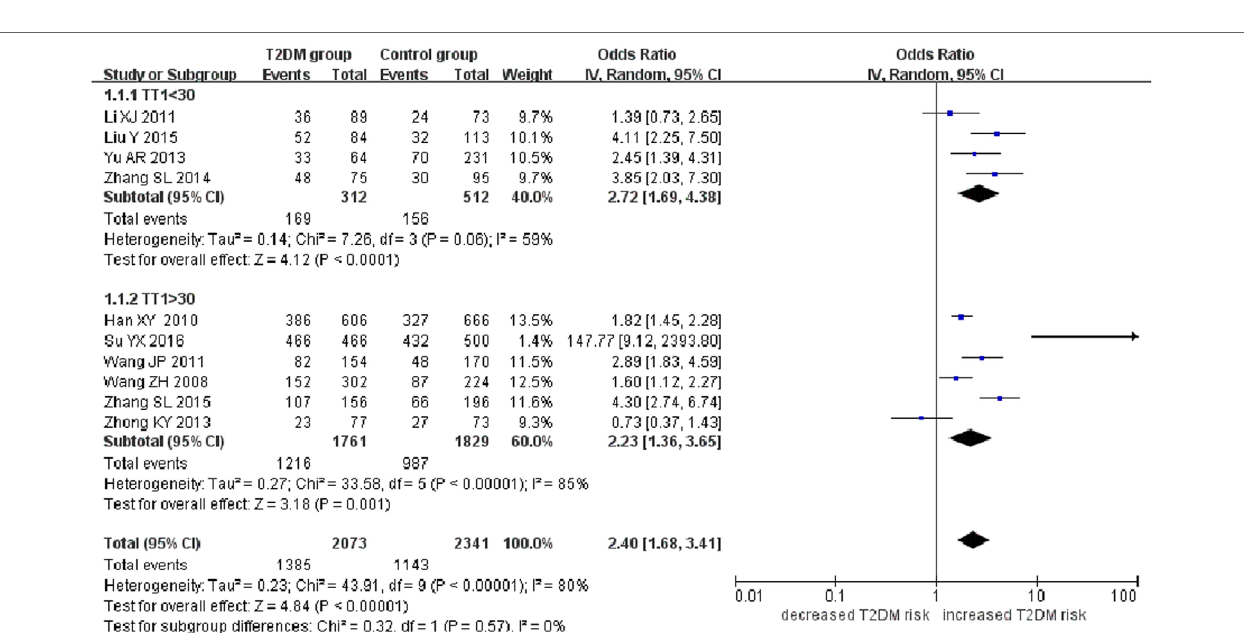
FiGURe 2 | Forest plot of type 2 diabetes mellitus associated with SLC30A8 gene rs13266634C/T polymorphism in the Chinese population under a recessive genetic model (TT vs. CT + CC).